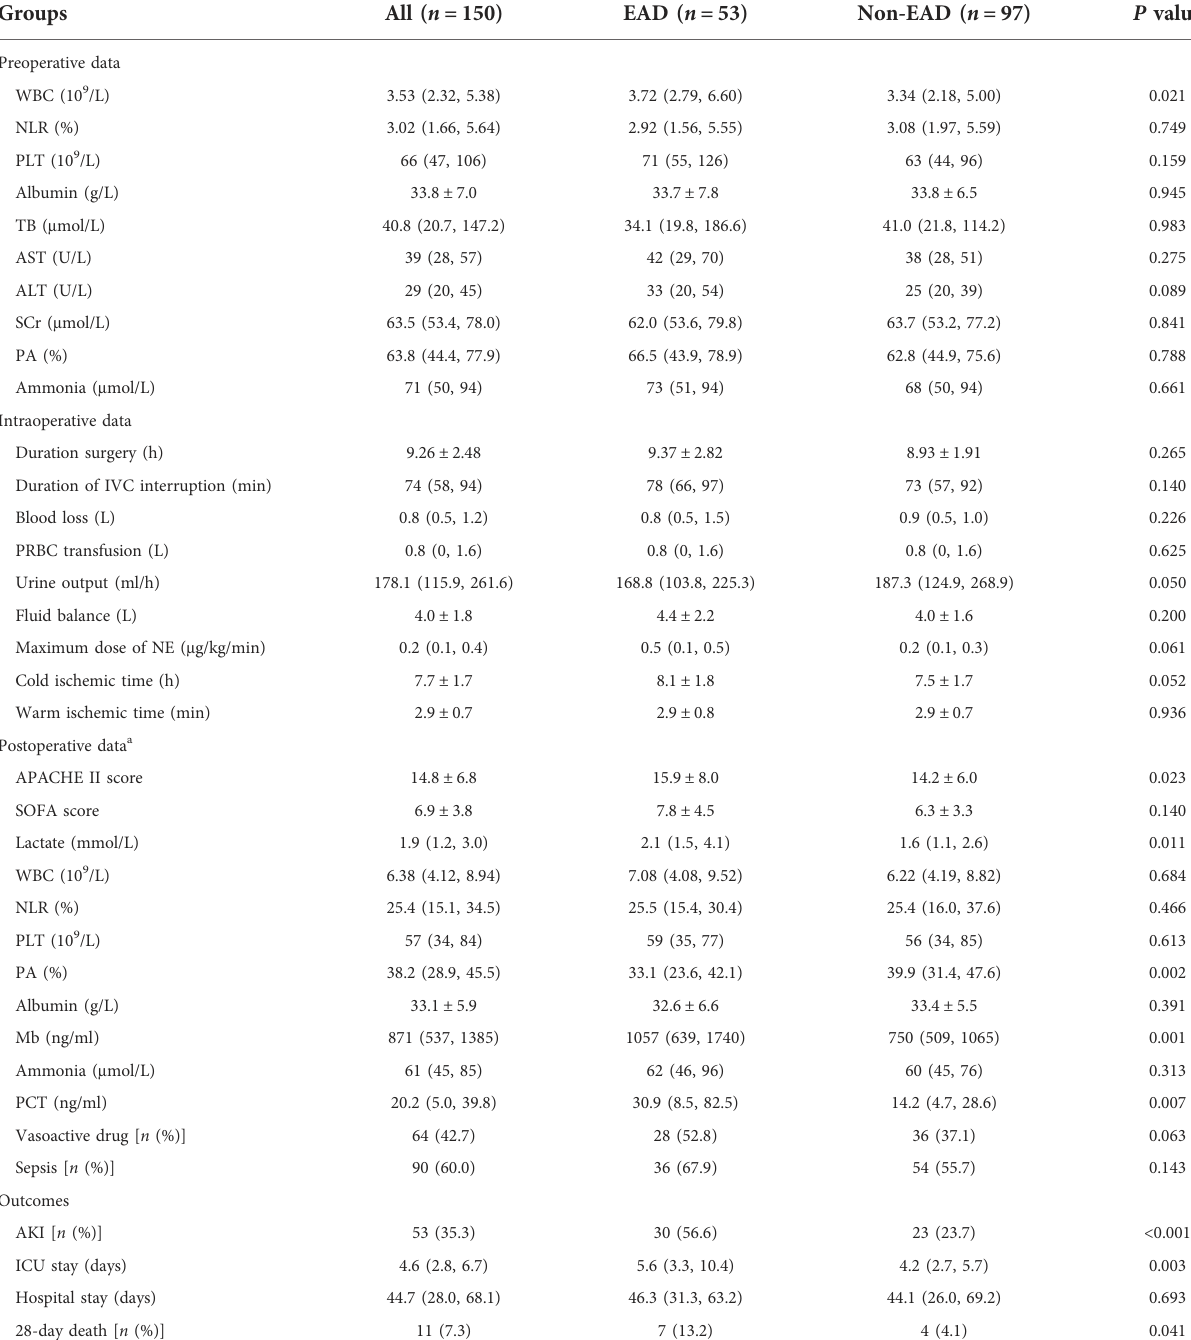
TABLE 2 Comparison of perioperative variables in the two groups.